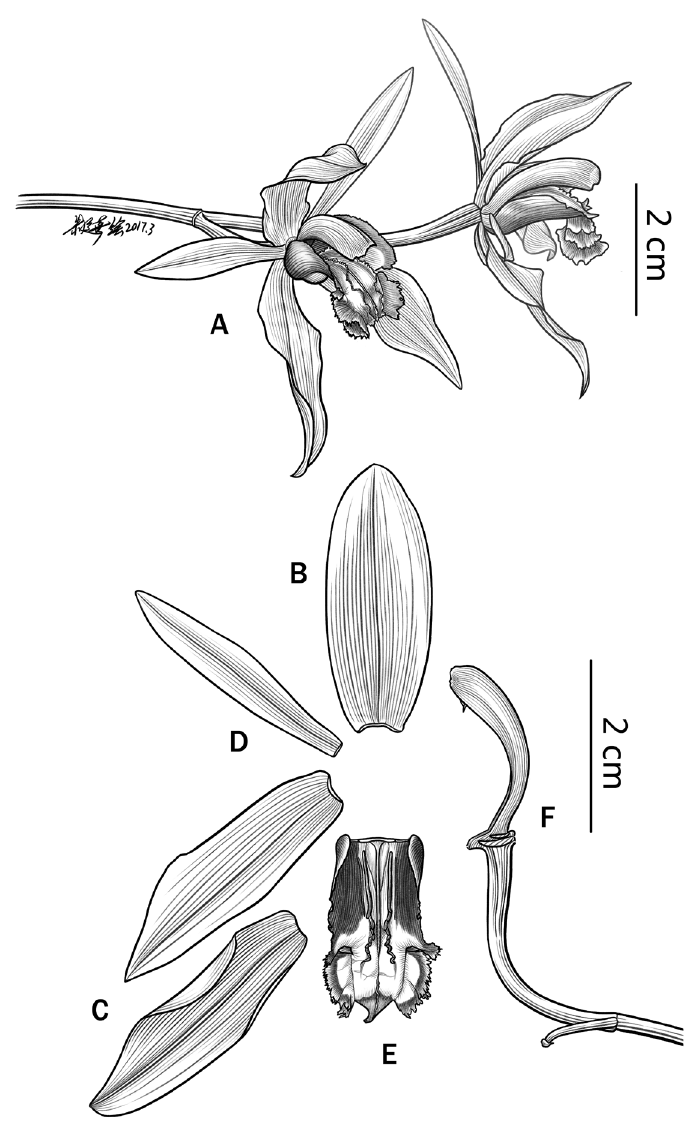
Figure 1. Coelogyne putaoensis X.H. Jin, L.A. Ye & Schuit. A Inflorescence B Dorsal sepal C Lateral sepals D Petal E Lip F Lateral view of column. Illustration by Yunxi